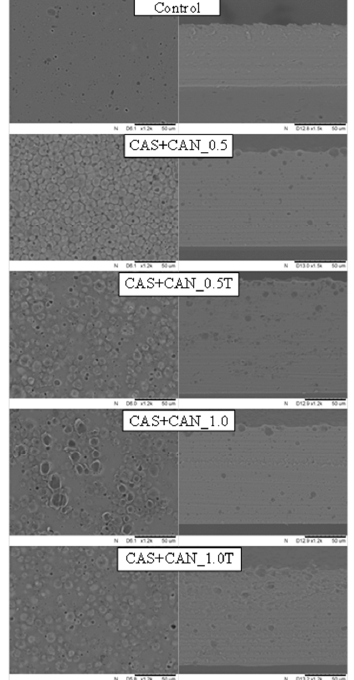
Figure 3. Scanning electron micrographs of surfaces (×500) and cross-sections (×1500) of sodium caseinate films without and with candelilla wax at 0.5 and 1.0%. Abbreviations: CAS—sodium caseinate, CAN—candelilla wax, T—Tween-80.